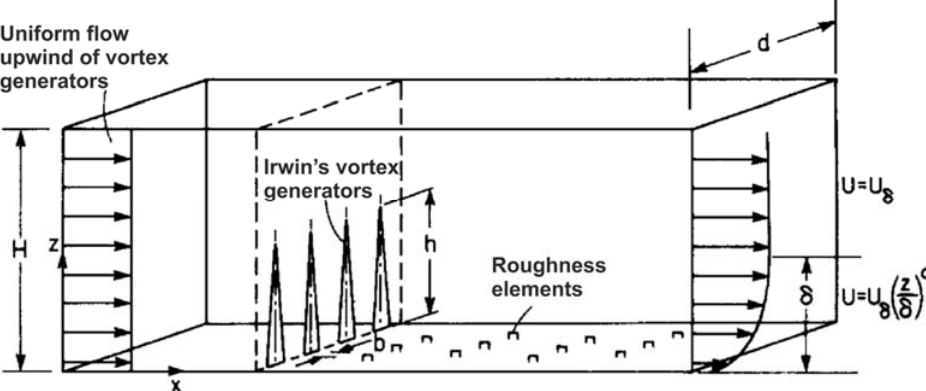
Figure 4. The most used devices for development of atmospheric boundary layer (ABL) in wind tunnels including Irwin’s spires and roughness elements (adapted from [30] ‐ Copyright 1981, Elsevier).